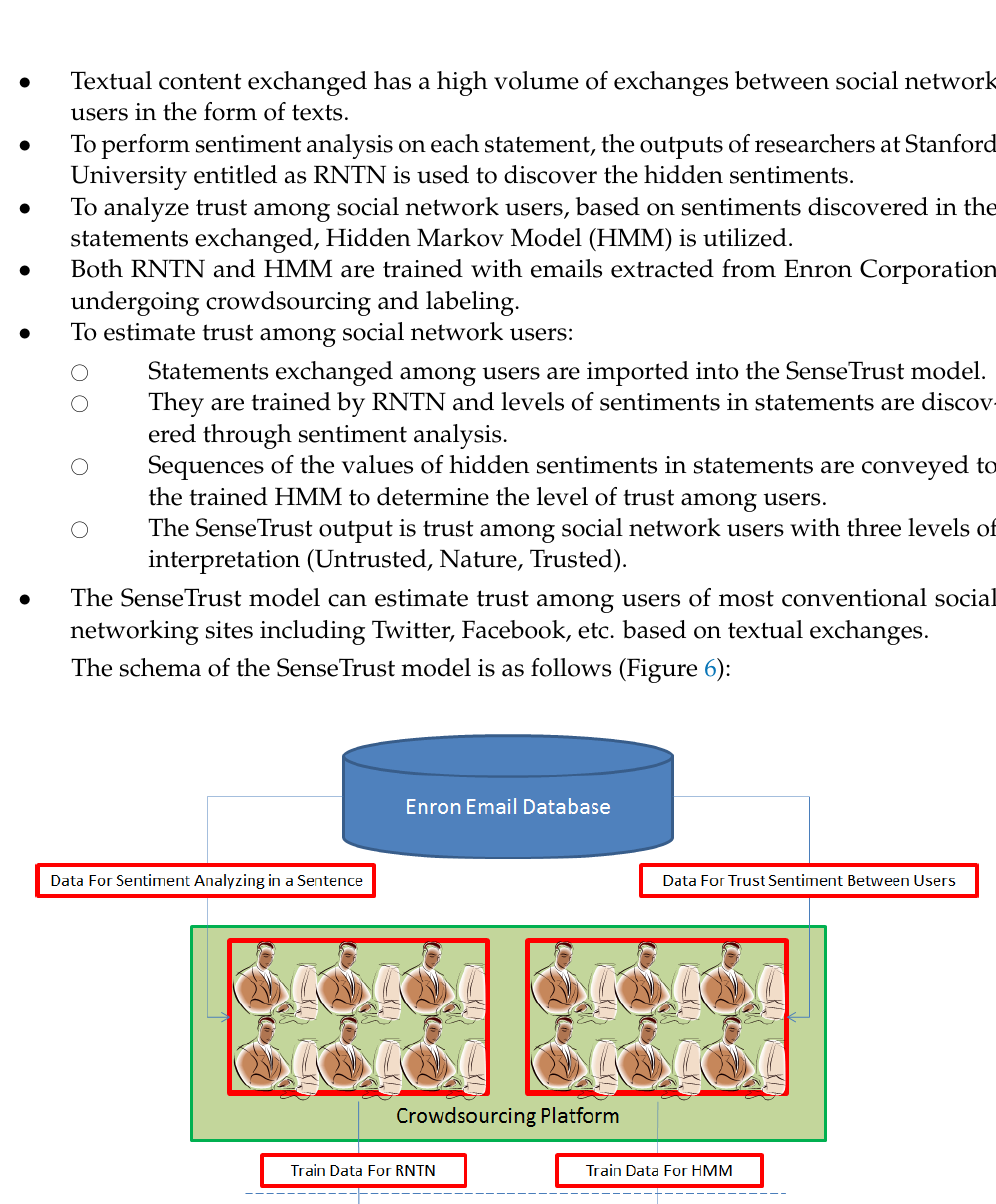
Table 5. Experimental